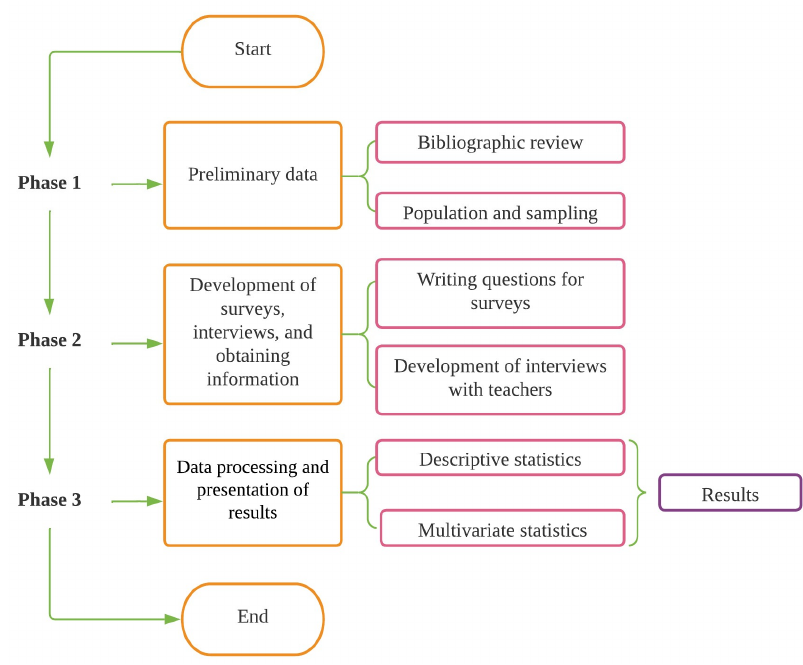
Figure 2. Data science diagram .